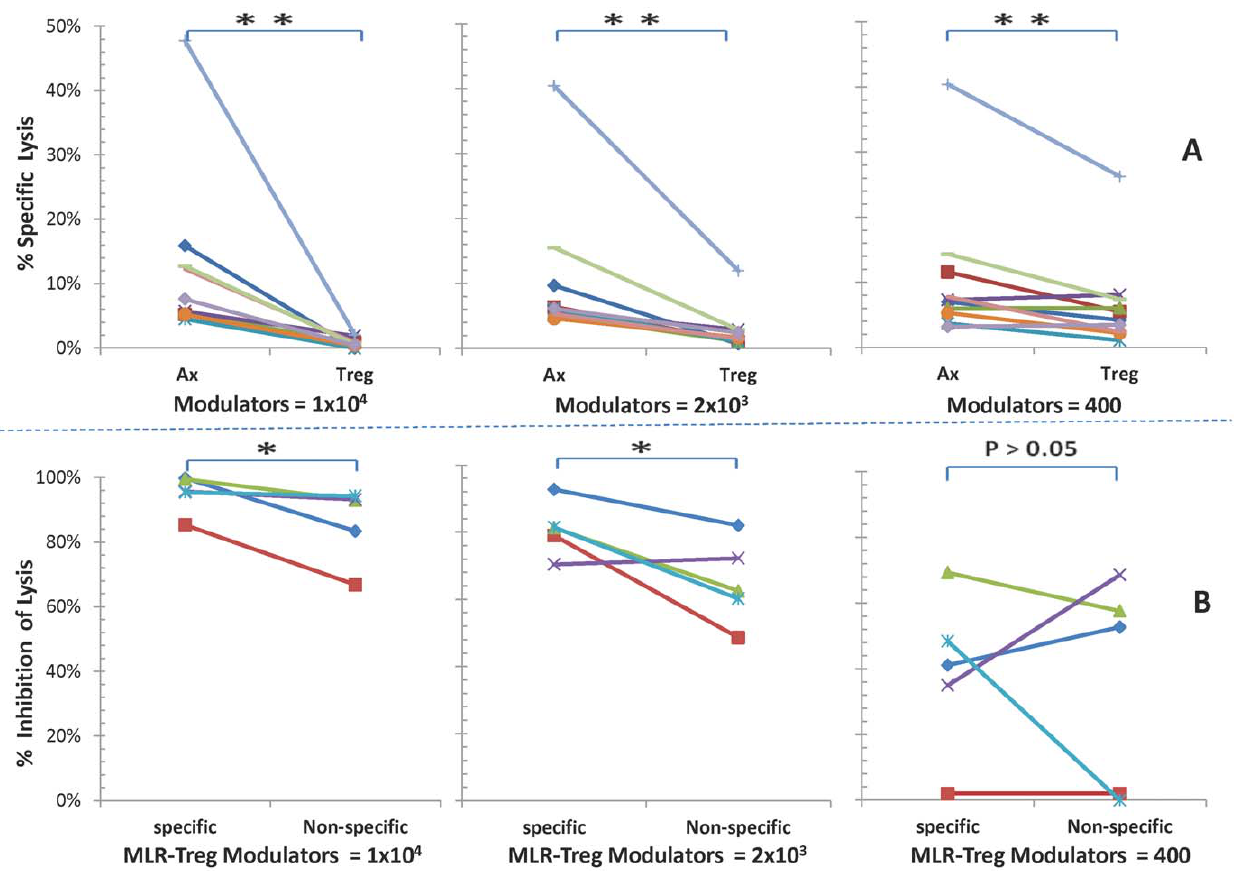
Figure 7. MLR-Tregs allospecifically regulate cytotoxic activity in micro-CML generated by purified CD8 + plus purified autologous CD4 + responders. Micro-CML inhibition assays were performed with purified CD8 + responders as described in Figure 5, but in presence of purified CD4 + cells autologous to the responders; the data are depicted as: (A) Percent specific lysis: against the specific stimulator used both in MLR-Treg generation and the micro-CML readout. The lysis of target cells was decreasingly inhibited by decreasing concentrations of modulating MLR-Tregs (points on the right side) as opposed to none seen using control modulators (points on the left side) (**=p , .01; n=10). (B) Percentage inhibition: the percent specific lysis values were converted to percent inhibition. Noteworthy is that in contrast with the findings depicted in Figure 5B (but similar to those of Figure 4B), using the original vs third party stimulator/target cells, allospecific lytic inhibition was restored by using purified CD8 + to which purified autologous CD4 + cells were added (*=p , 0.05; **=p , 0.01; n=5).